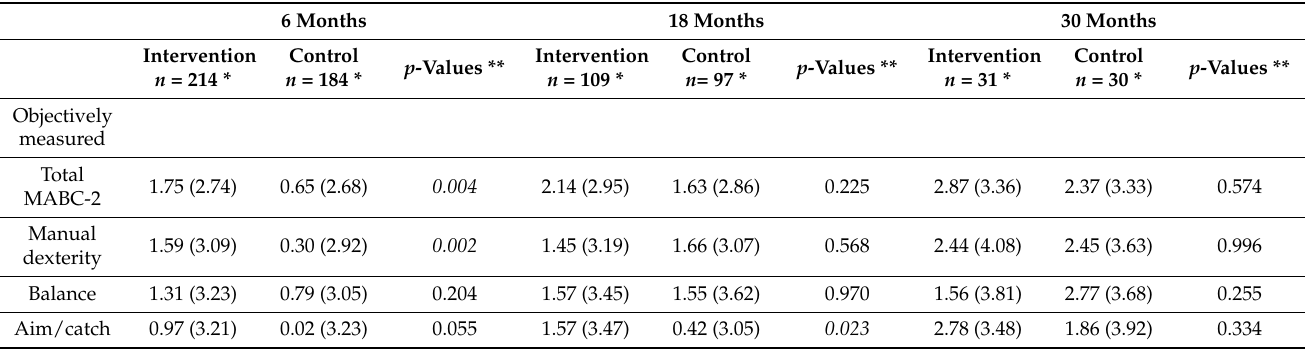
Table 5. Change scores from baseline to follow ‐ up by intervention group. Motor skills measured using MABC ‐ 2 in pre ‐ school